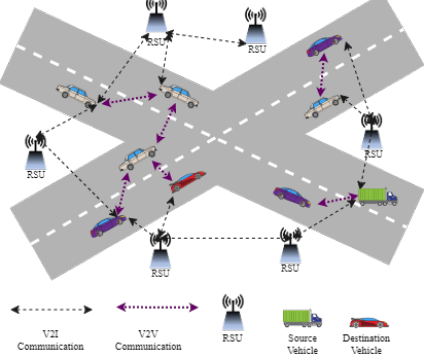
Figure 2. VANETs junction